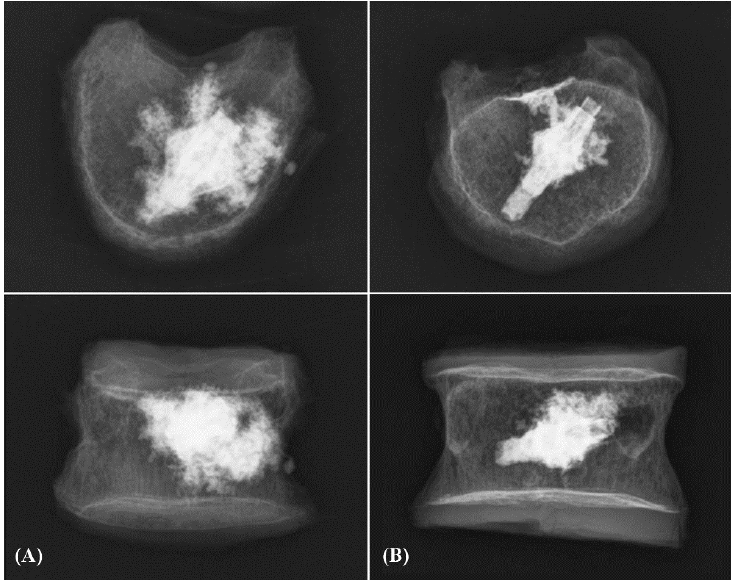
Figure 5. X-ray images showing vertebrae implanted with ( A ) EVA ® and ( B ) OsseoFix ® following bone cement injection. Top view ( upper ) and frontal view ( lower ).